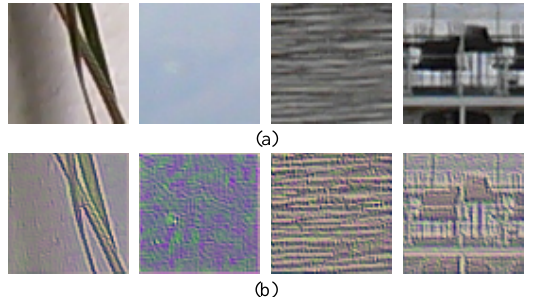
Figure 4. Visulization of typical pathes by the residual prediction module. ( a ) Original patches; ( b ) residual patches.